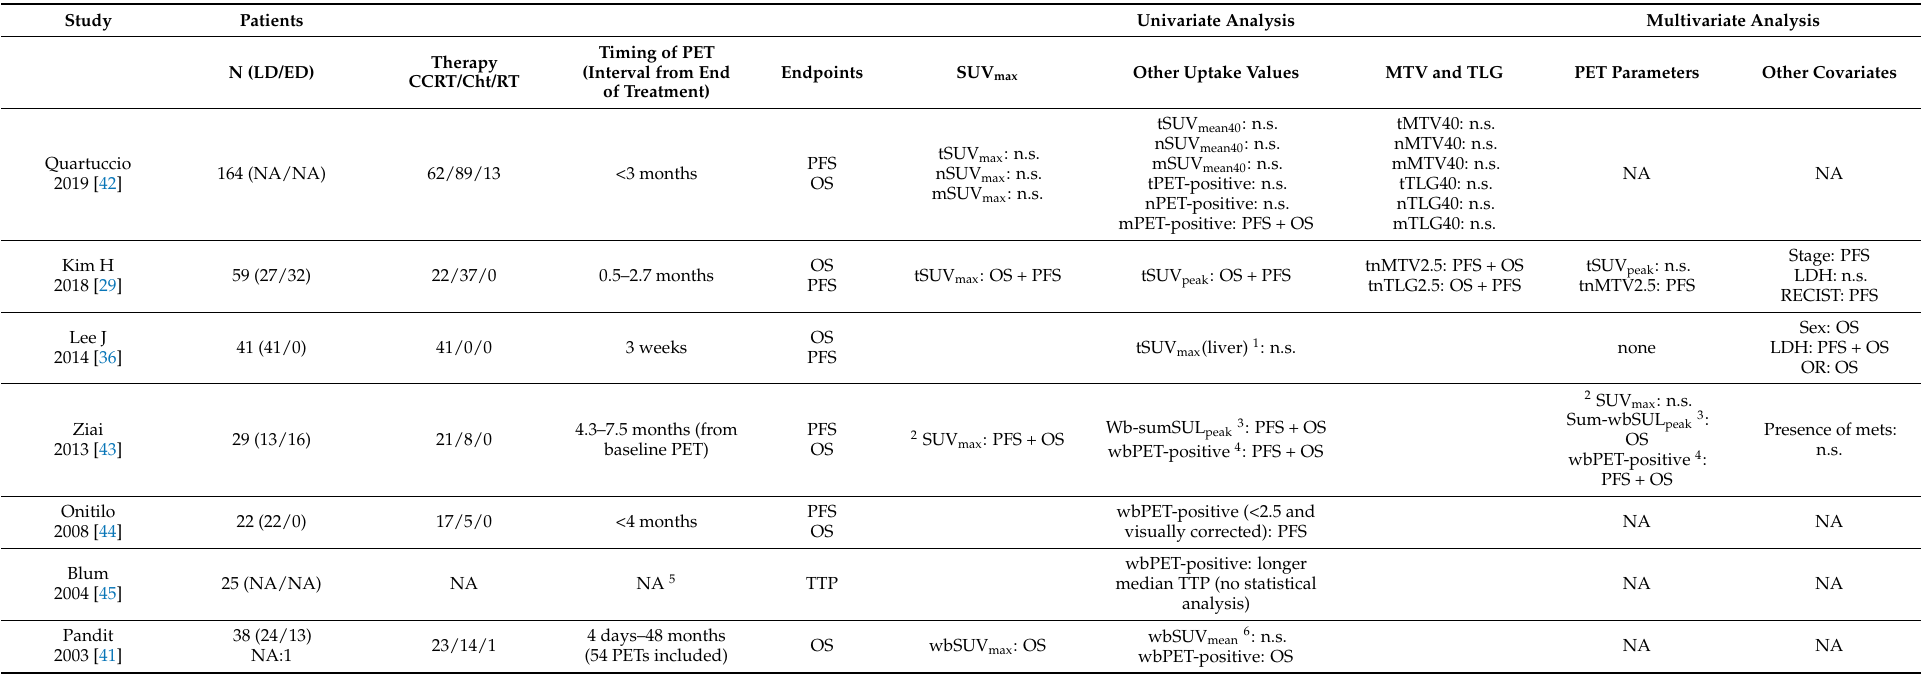
Table 3. Prognostic value of post-treatment PET